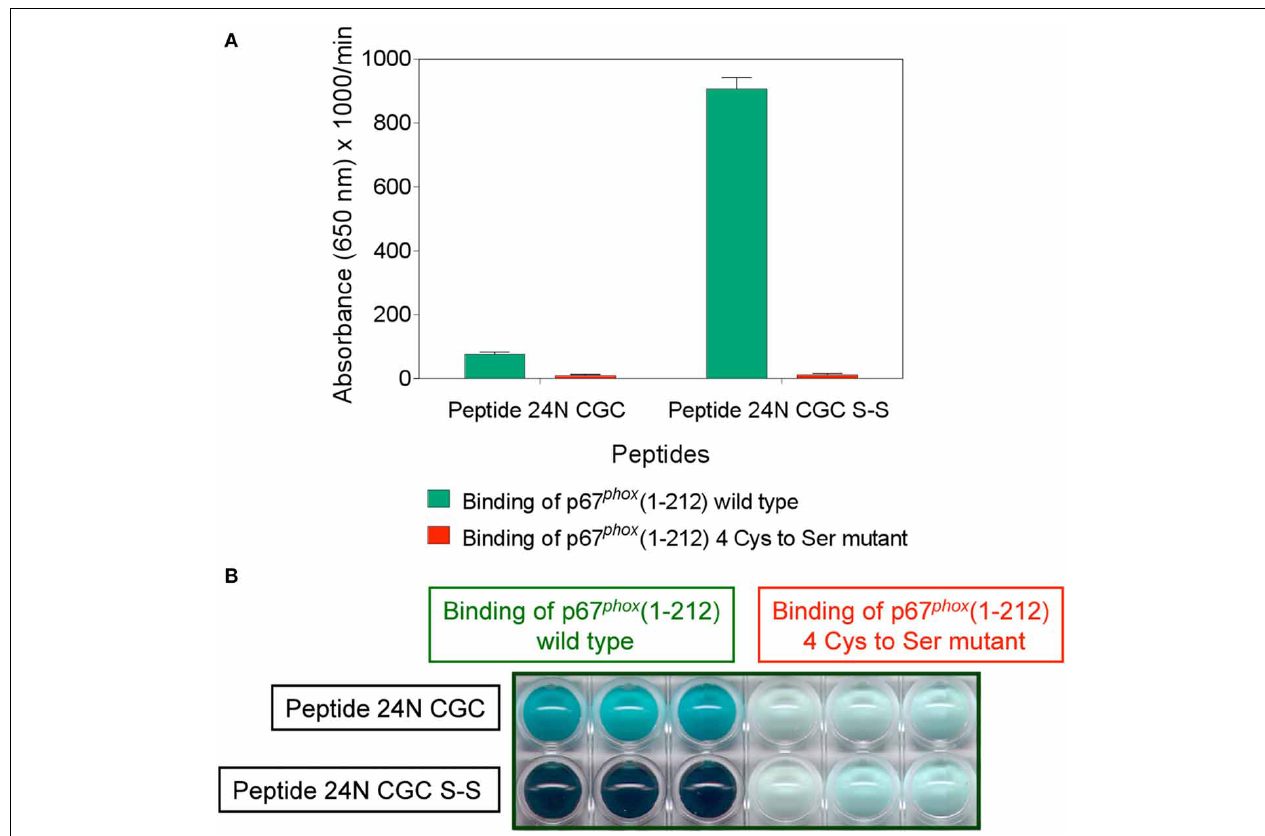
FIGURE 12 | Mutating all four cysteines in p67 phox (1–212) eliminates its ability to bind to Nox2 peptide 24. Binding of wild type p67 phox (1–212) and p67 phox in which 40 Cys, 45 Cys, 121 Cys, and 165 Cys were mutated to Ser, in solution, to surface-attached Nox2 peptide 24 (357–371), with an N-terminal biotin tag, in the dithiol form (labeled 24N CGC), and with an intramolecular disulfide bond between cysteines C369 and C371 (labeled 24N CGC S-S), was assessed. The